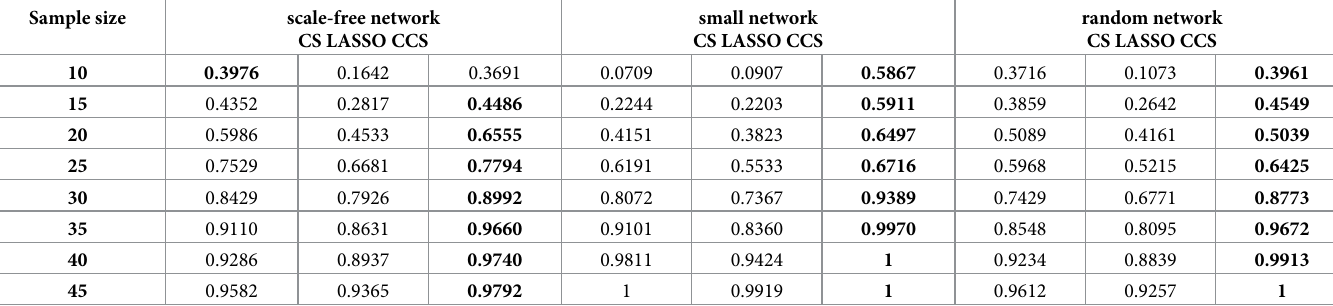
Table 4. The success rate of three methods on different types of networks ( N = 500, < k > = 6). Sample